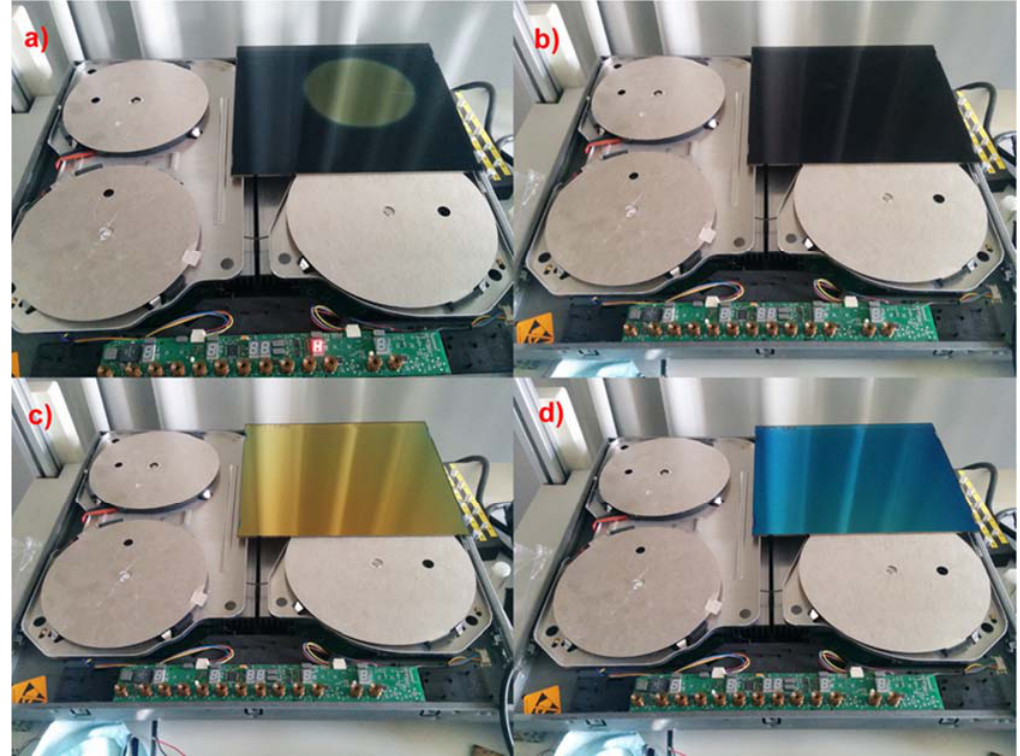
Figure 4. Some decorative coatings after abandonment test: ( a ) Navy/black coating with SnO 2 and Sst layers; ( b ) Navy/black coating with SiAlN x and Sst layers; ( c ) Yellow coating with SiAlN x and Sst layers; and ( d ) Sky blue coating with SiAlN x and Sst layers.